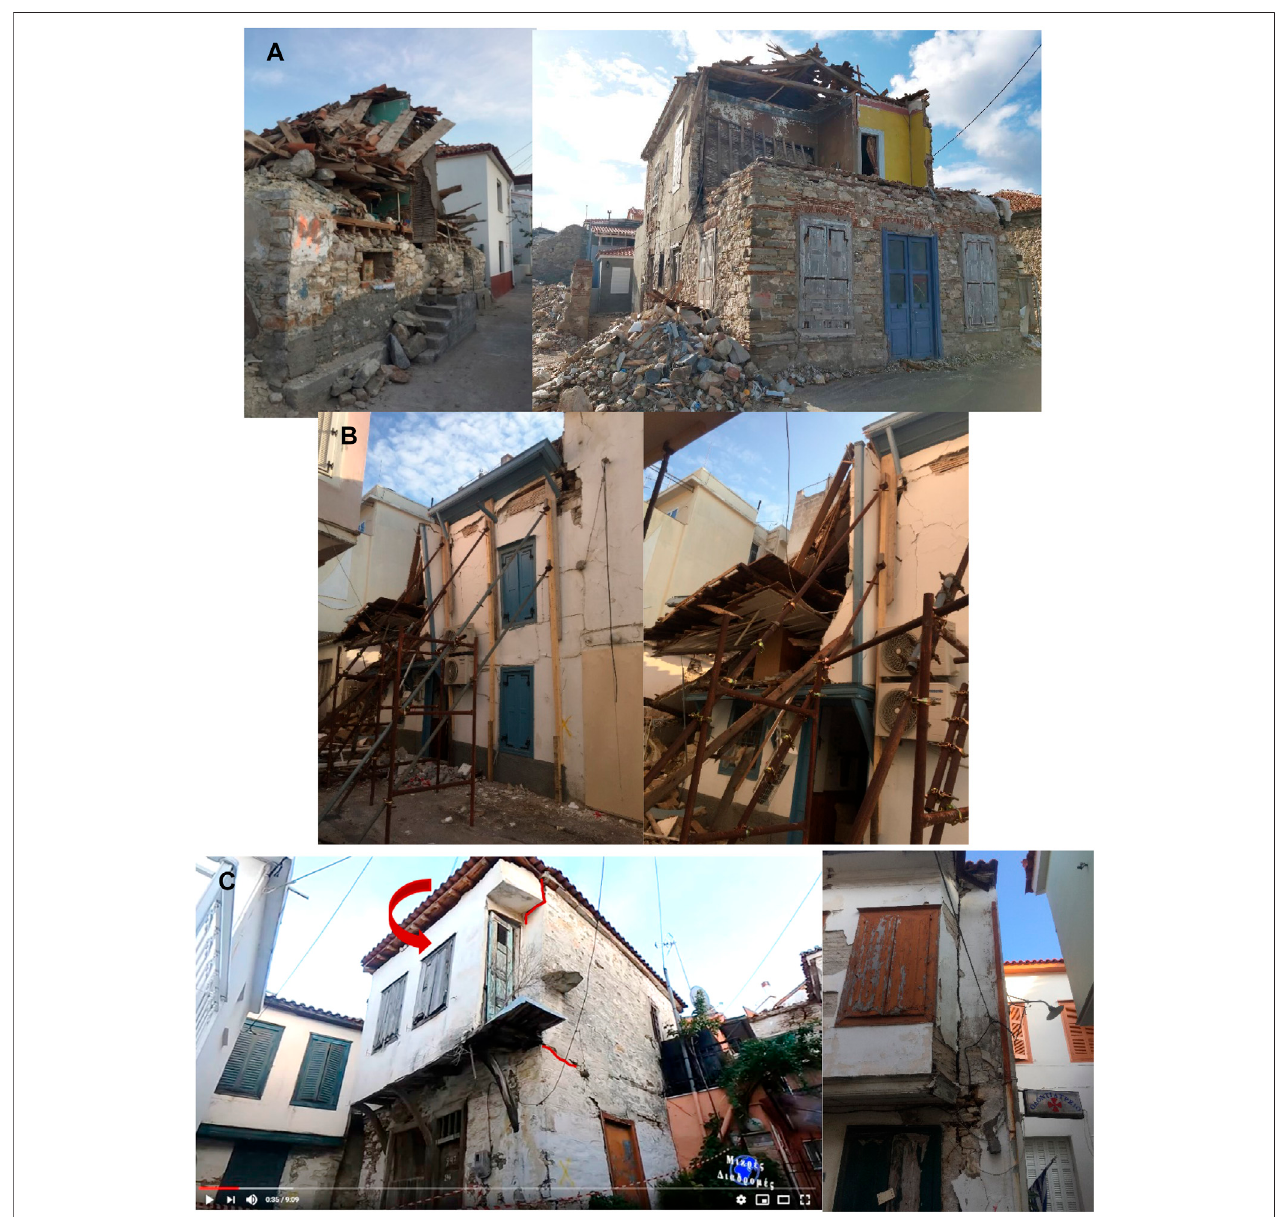
FIGURE3| Examplesofdamagetotimberframingintimber-masonrystructures. (AandB) :progressivefailureoftheupper fl oortimberframingandtheroof[DG4- DG5]; (C) Overturning of the jetty in timber-masonry structures [picture on the left from Mikres Diadromes Samou, 2020] [DG3] (all in Samos, Greece).